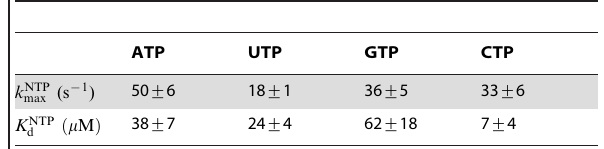
Table 1. Parameters Values.